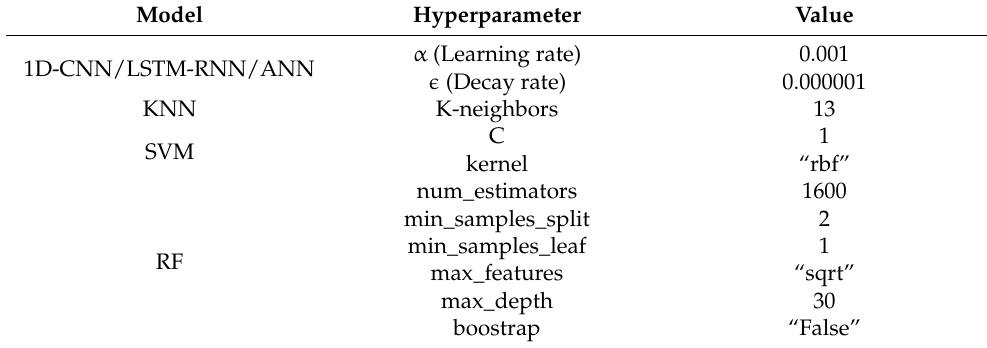
Table 1. List of hyperparameters for each model.